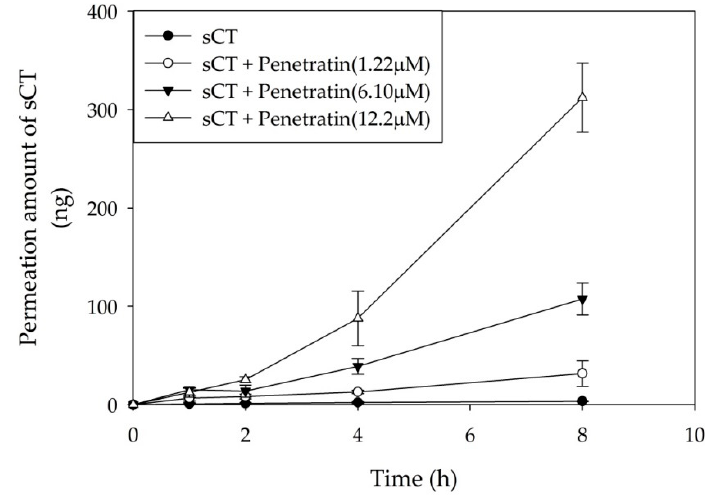
Figure 7. Permeation profile of sCT across porcine buccal tissues. All data were represented by mean ± S.D ( n = 3).